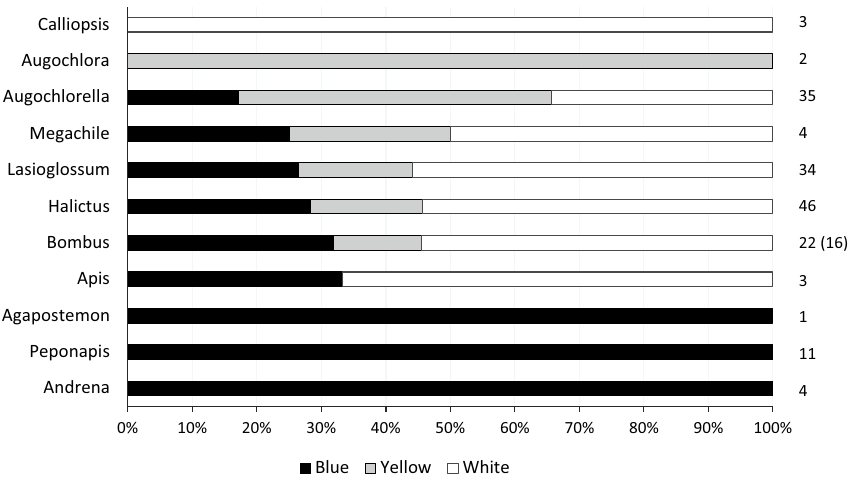
Figure 2. Proportion of individual bees from each bee genus captured by each color pan trap. The number at the end of a row represents the total number of bees of a given genus caught by pan traps. For the genus Bombus , the number in parenthesis indicates the number of individuals when the species B. impatiens is